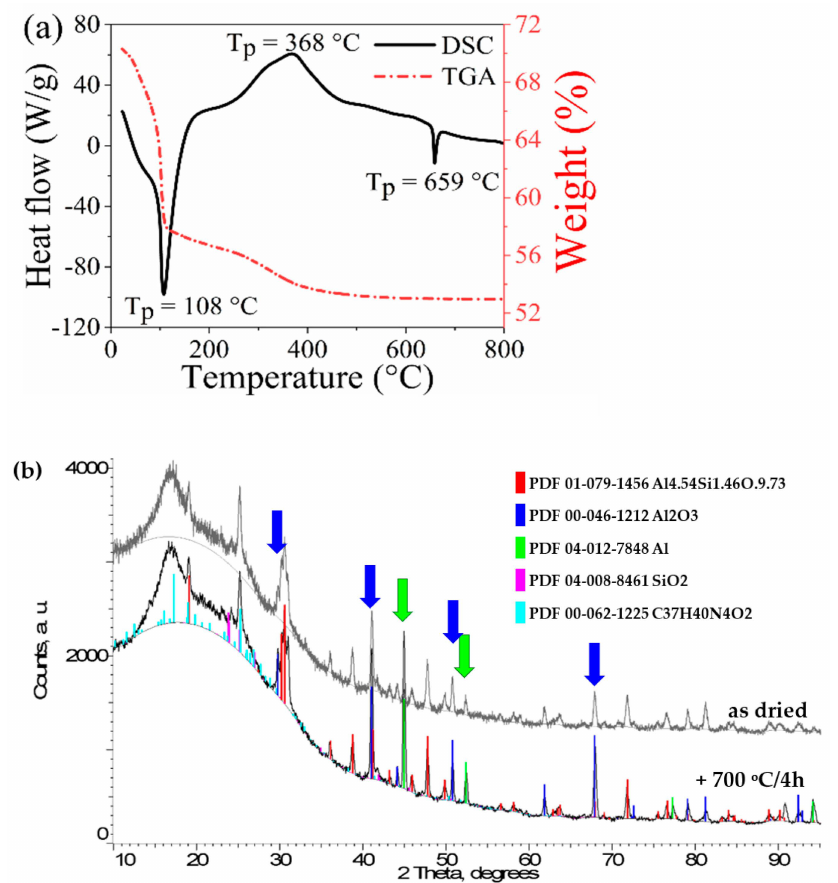
Figure 6. TGA and DSC curves representing weight loss and heat flow during the heating of plain Thermacoat™ ( a ). XRD spectra of this material in both as-dried condition 200 ◦ C/2 h and after additional heat treatment at 700 ◦ C/4 h ( b ). Green and blue arrows denote the position of lines corresponding to the α -Al and Al 2 O 3 phases,